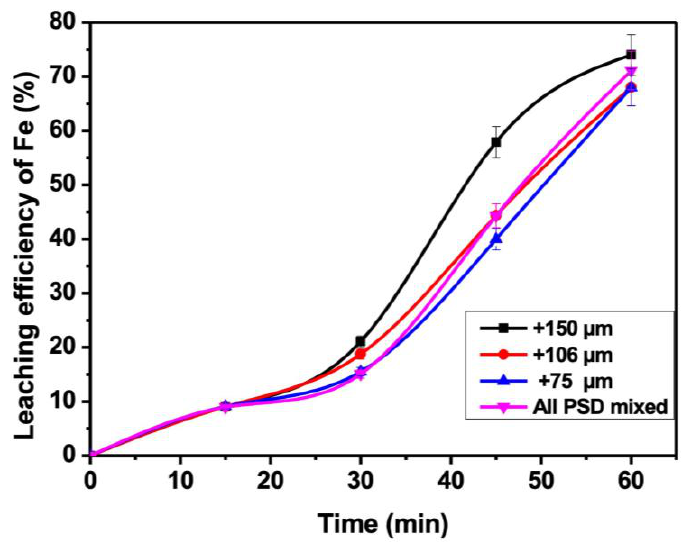
Figure 4. The effect of particle size distribution on leaching efficiency of Fe. Conditions: 7.5 M HCl; solid–liquid ratio, 1:10; agitation speed, 350 rpm; agitation time, 60 min; temperature, 90 °C.